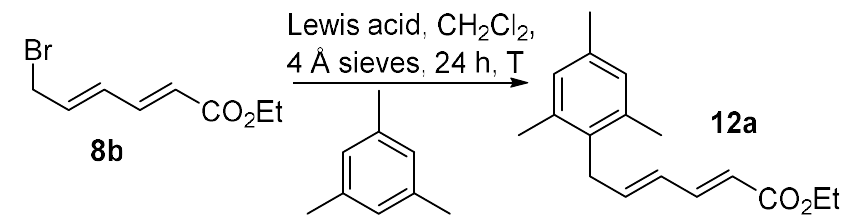
Table 2. Optimization of 12a